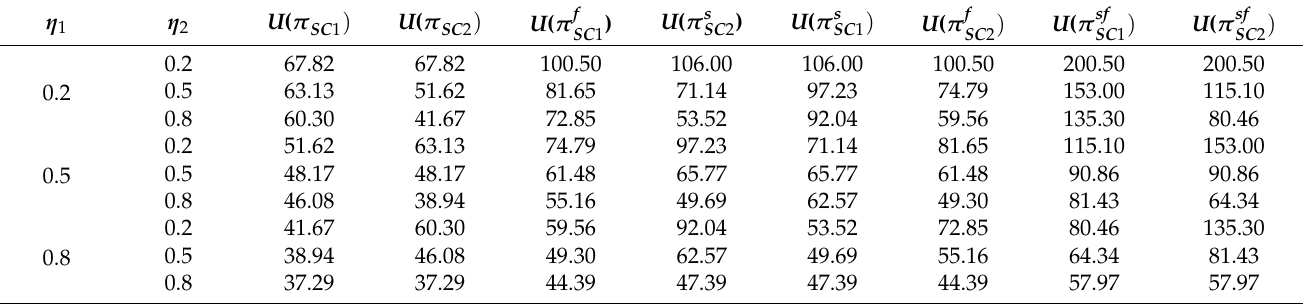
Table 2. The total expected utility of each supply chain varies with the degree of risk aversion.